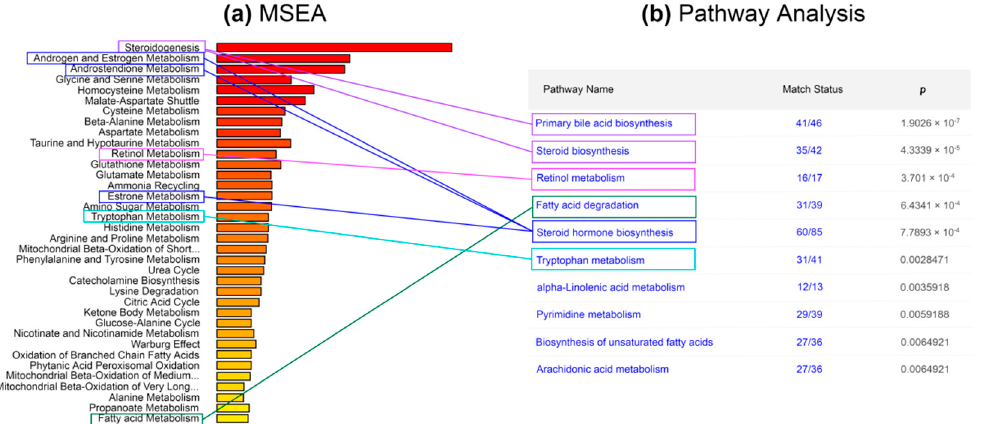
Figure 5. Enriched metabolic pathways in the third stage of obesity, MetaboAnalyst 4.0/5.0, web-version. ( a ) DIMS mass-spectra after processing with the DataAnalysis/MatLab pipeline were analyzed by the MSEA tool. ( b ) DIMS mass-spectra after MALDIquant/Mummichog pipeline processing were analyzed with the Pathway Analysis tool. “Match Status” indicates the number of annotated metabolites/number of known metabolites of the KEGG pathway.